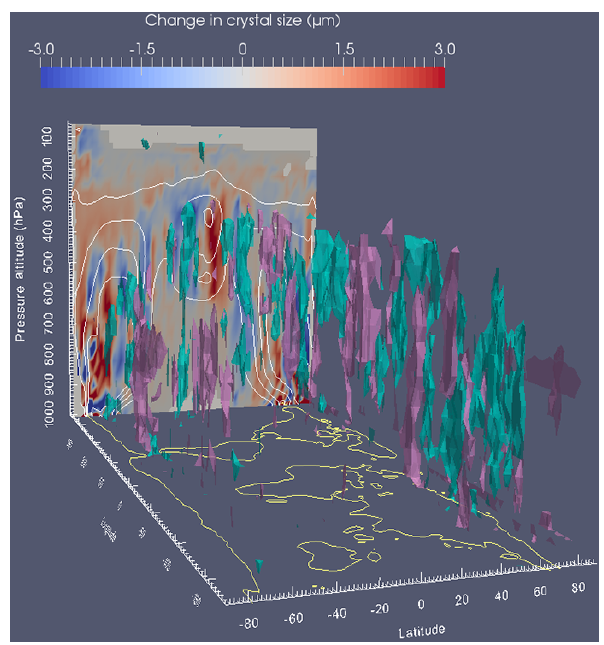
Figure 6. Visualisation of changes in the effective radius of ice crys- tals. The back panel displays the statistically significant absolute changes in zonal average ice crystal size in µm. The white contours depict a mean ice crystal size and therefore mark regions with large and smaller crystals. Additionally, the isosurfaces represent the re- gions for substantial absolute changes for the effective ice crystal sizes (turquoise for negative and purple for positive) due to the LNO x